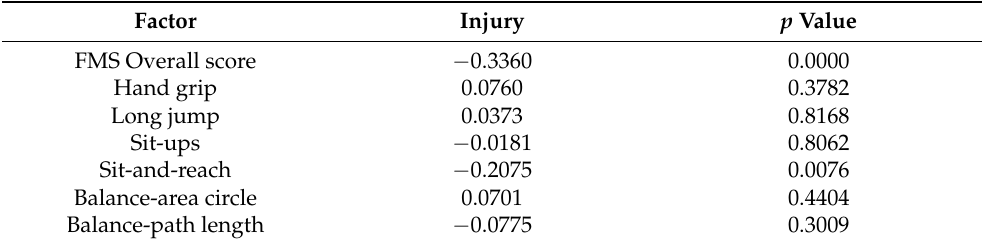
Table 2. Spearman correlation for injuries and physical performance tests scores, FMS overall score ( p < 0.05).